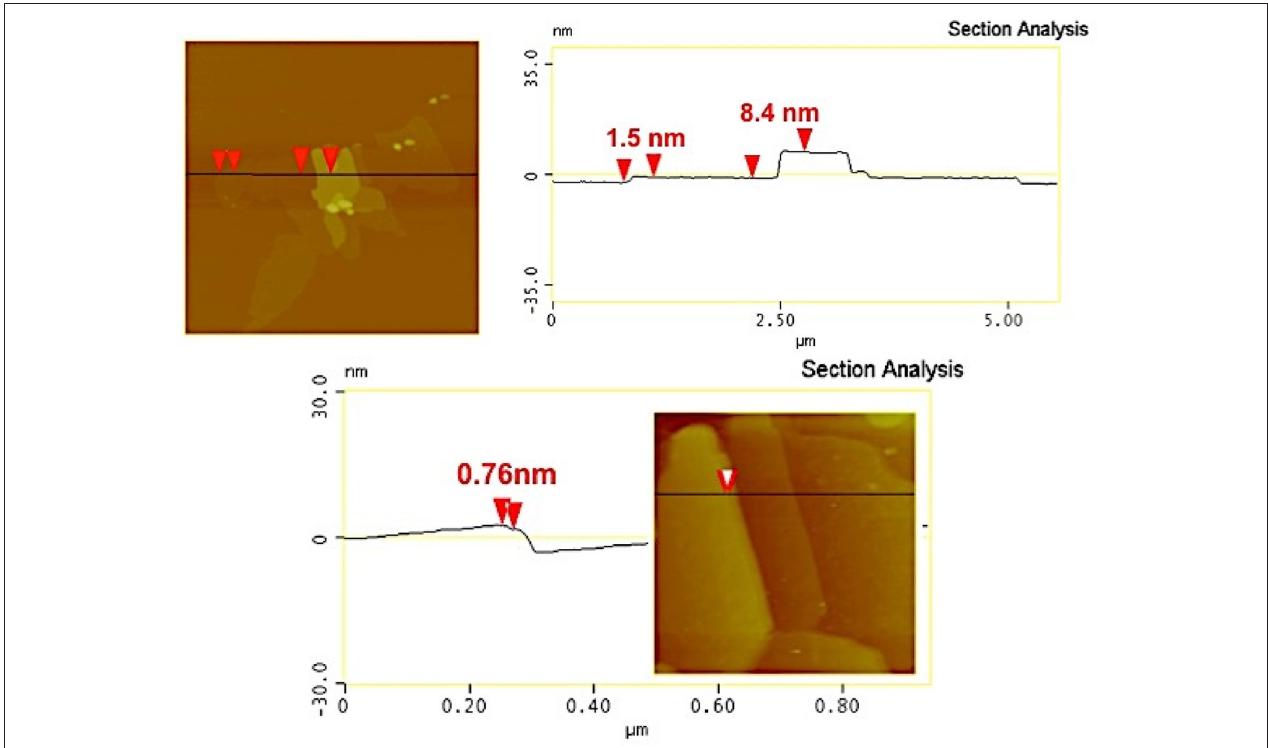
FIGURE 4 | AFM cross-section analysis of MoS 2 /r-GO nanocomposite (a single MoS 2 layer can be distinguished from a package of few-layer MoS 2 sheets; picture